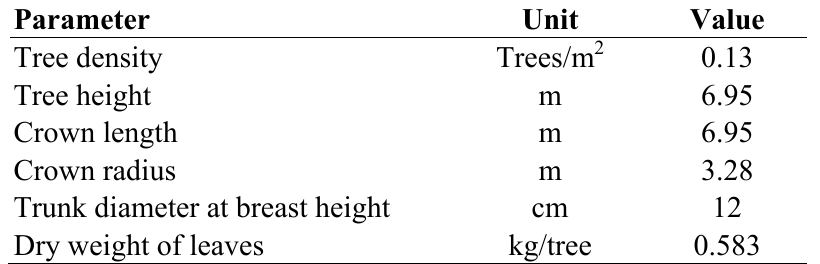
Table 5. Main parameters of the Abisko forest stand for the FRT model.